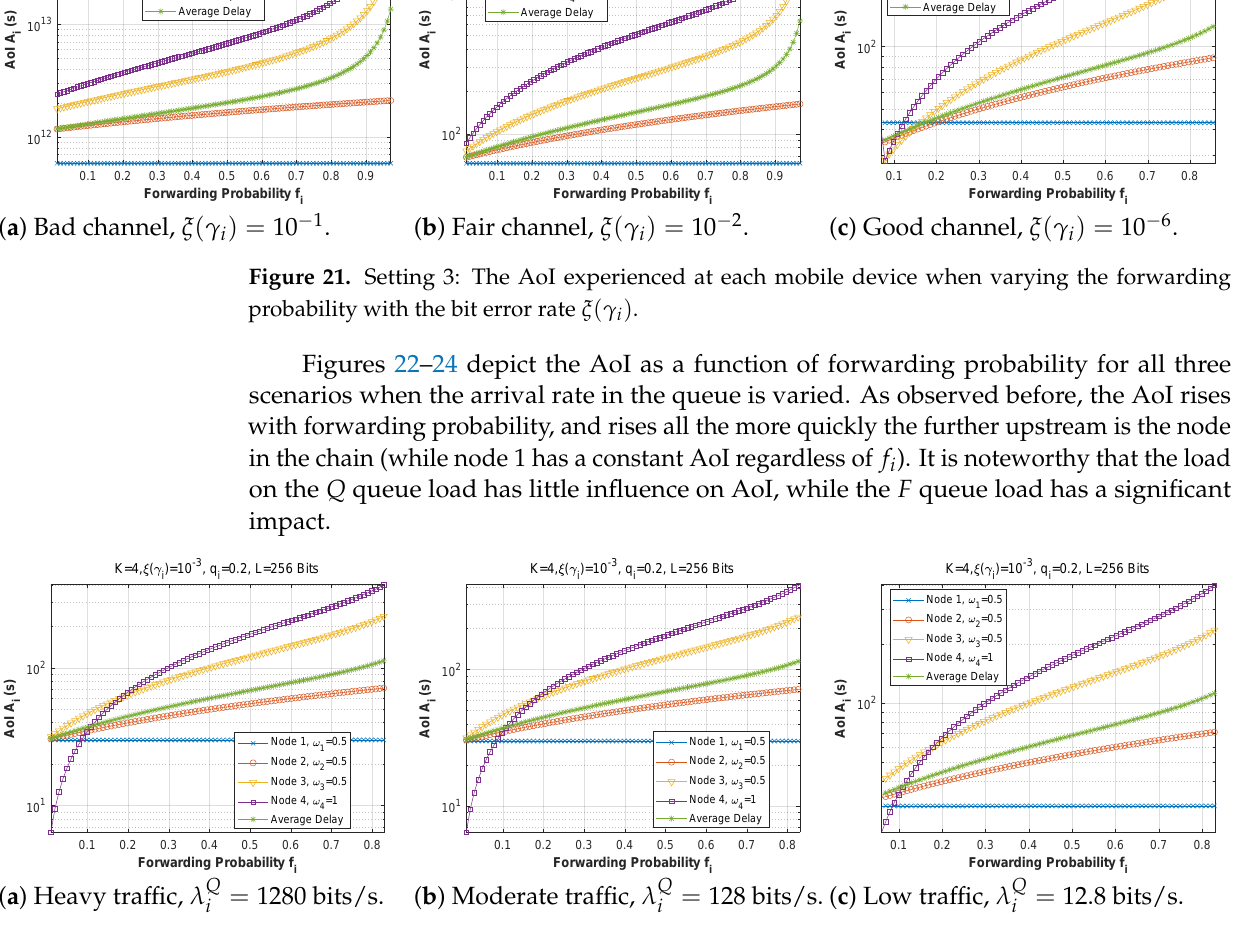
Figure 22. Setting 1: The AoI experienced at each mobile device as a function of forwarding probabil- ity f i for various values of the arrival rate λ Q i